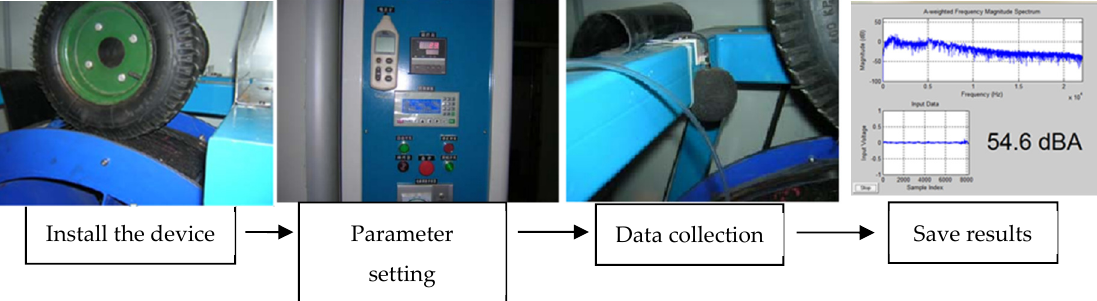
Figure 5. The noise acquisition process.